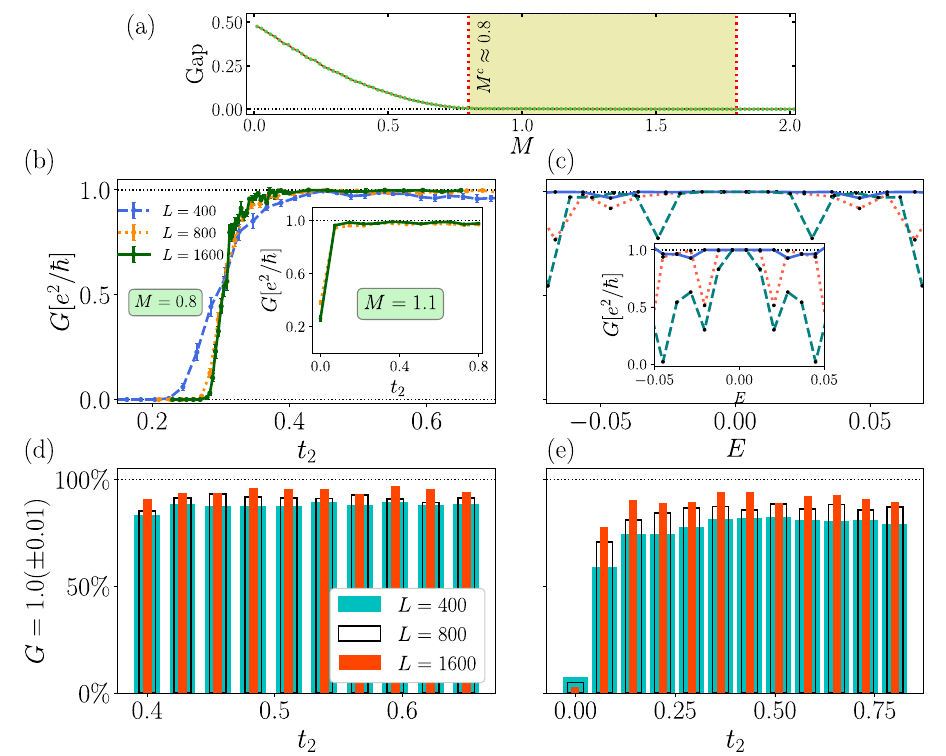
linear system size L = 100 and second-nearest-neighbour hopping t 2 = 0.3. The gapped-gapless phase transition coincides with the trivial-topological fractal transition at M c ≈ 0.8. The average is taken over 150 random con fi gurations and the error bars (not shown) are of the order of 10 − 3 . b Two-terminal conductance G as a function of t 2 at ( E , M ) = (0, 0.8) signifying the transition from a spectral insulator to a topological random fractal phase. E indicates the energy at which the conductance is calculated. (Inset) Same for ( E , M ) = (0, 1.1). c Conductance for different individual realizations of topological random fractals as a function of energy for ( t 2 , M ) = (0.45, 0.8) and (inset) ( t 2 , M ) = (0.25, 1.1) for L = 1600. d Percentage of the samples falling into 1% of the